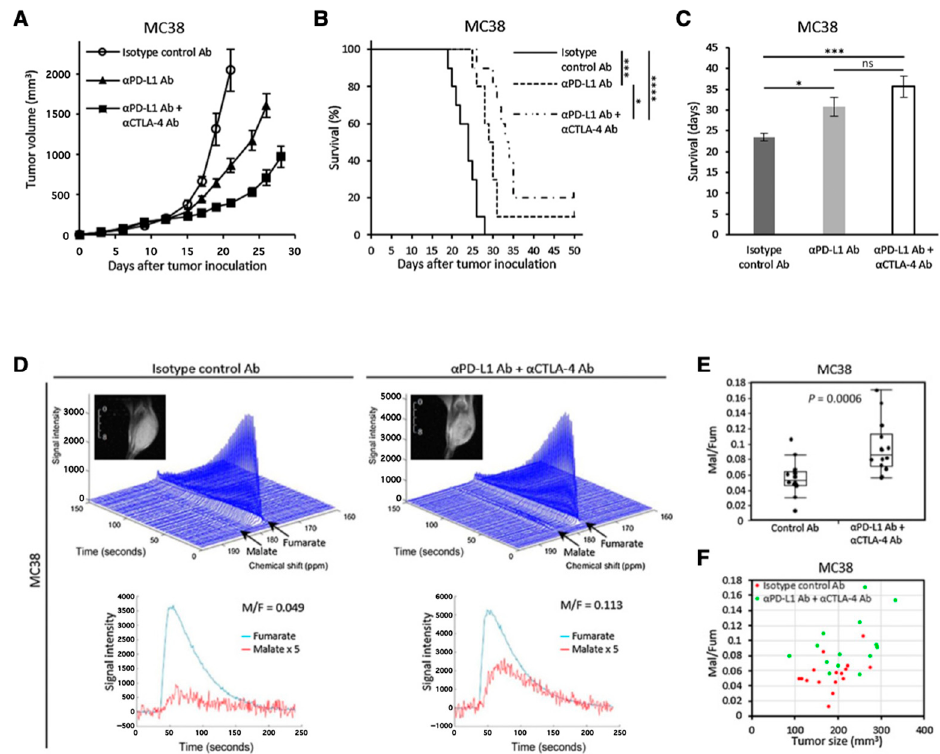
Figure 11. Use of [1,4- 13 C 2 ]fumarate for detecting early response of tumor to immunotherapy. Growth curve ( A ) and Kaplan–Meier survival curve ( B ) of MC38 tumors inoculated in mice. The mice were treated with isotype control Ab, anti-PD-L1 Ab, or combination anti-PD-L1 Abþanti-CTLA4 Ab on days 9, 12, and 15 after the tumor inoculation. Survival refers to the time before reaching the tumor volume of 2000 mm 3 . ( C ), Bar plot of the survival from ( B ). ( D – F ), 13 C-MRS of the hyperpolarized 13 C-fumarate metabolism in the MC38 xenografts. ( D ), Representative dynamic 13 C spectra and kinetics of fumarate and malate in the MC38 tumor treated with isotype control Ab or anti-PD-L1 Ab + anti-CTLA4 Ab. ( E ), The malate to fumarate ratio in the MC38 tumors. ( F ), Correlation between the malate to fumarate ratio and the tumor volume. * p < 0.05, *** p < 0.001 **** p < 0.0001. ns: non-significant